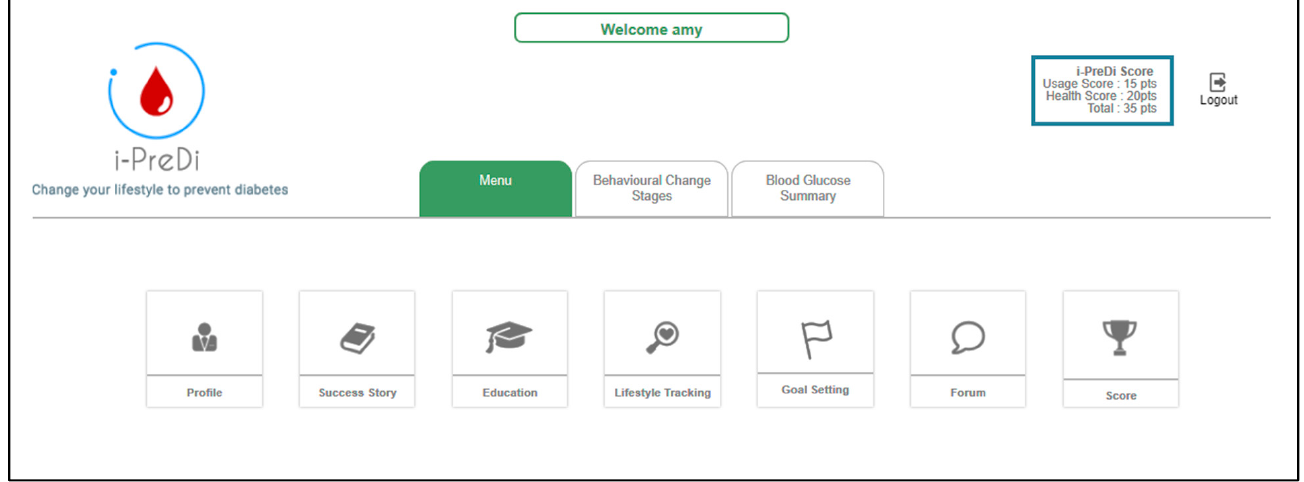
Figure 2. The dashboard of i-PreventDiabetes.